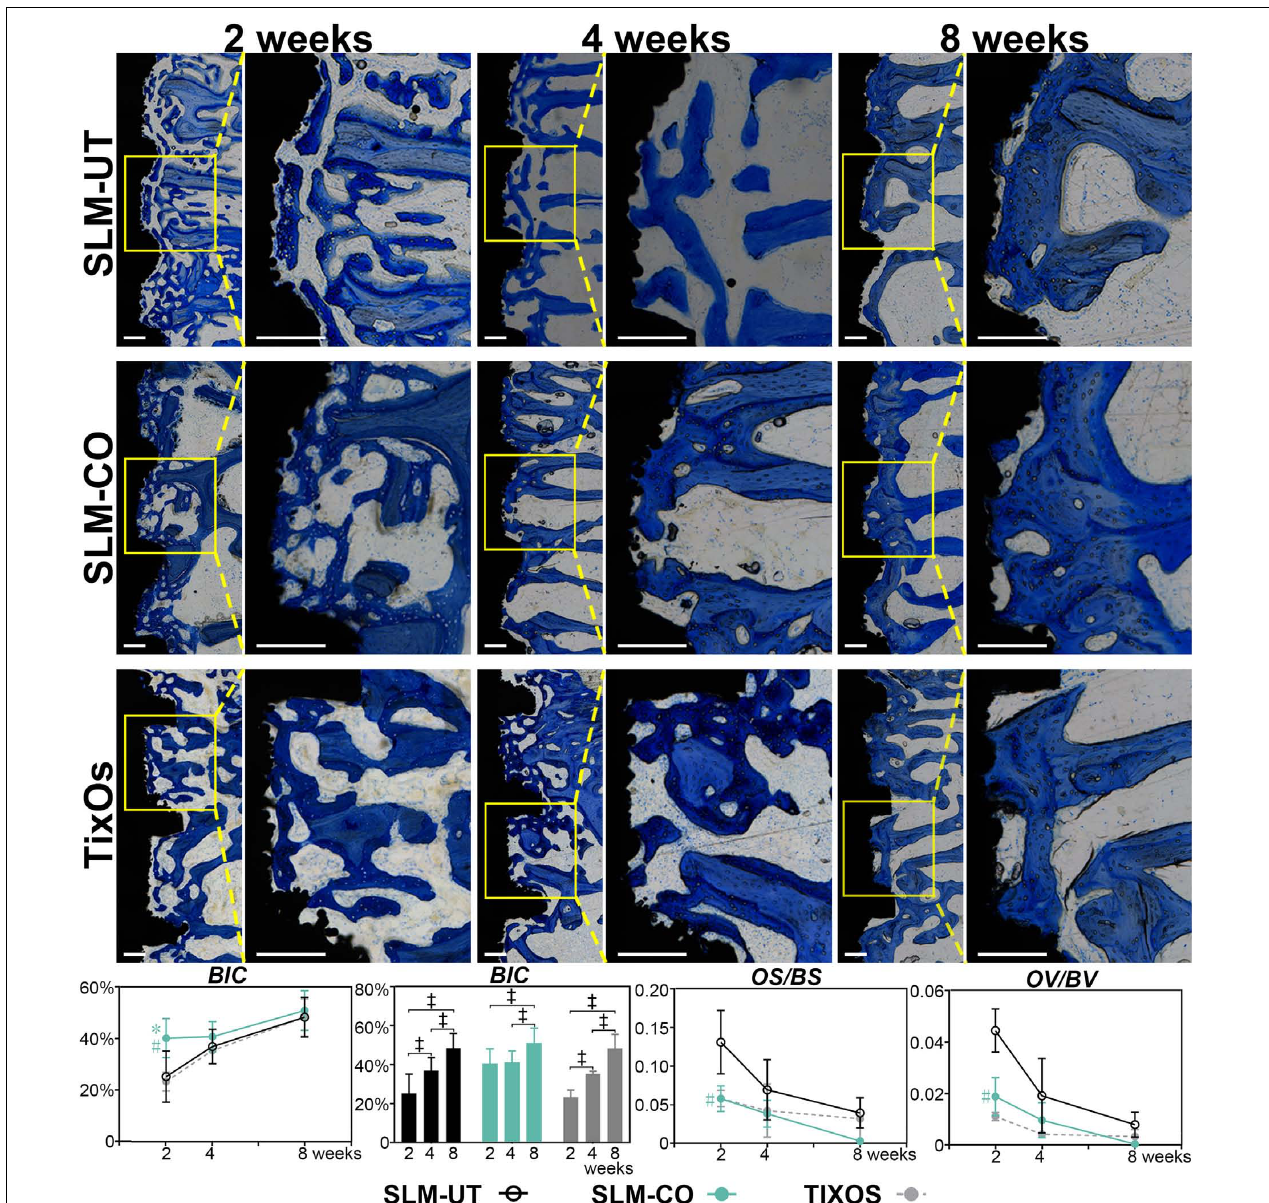
FIGURE 7 | The time sequence of osseointegration showed by Toluidine Blue O stained undecalcified histological sections and the corresponding quantitative analysis of bone-to-implant contact (BIC) and osteoid content ( ‡ significant difference of BIC between different time points, P < 0.05, *significant difference between SLM-CO and TixOs, P < 0.05, # significant difference between SLM-CO and SLM-UT, P <